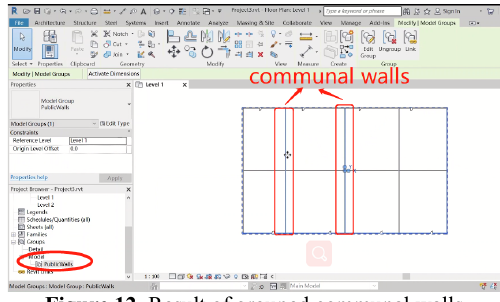
Figure 12. Result of grouped communal